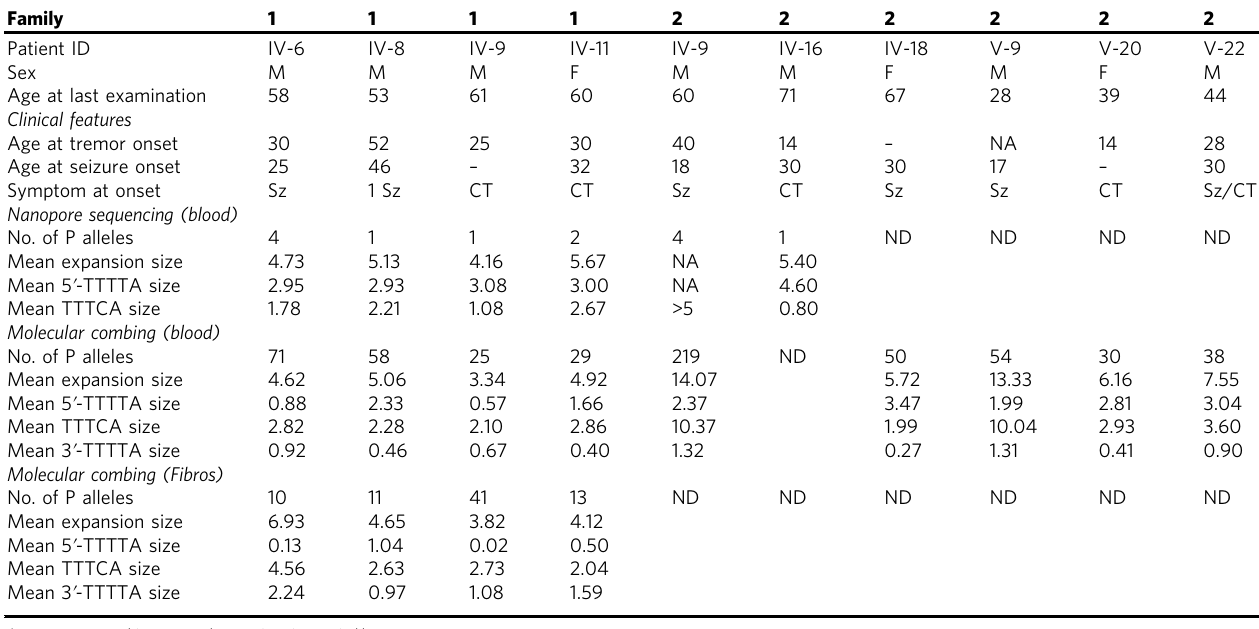
Table 1 Summarized clinical features and expansion characteristics for 10 affected individuals